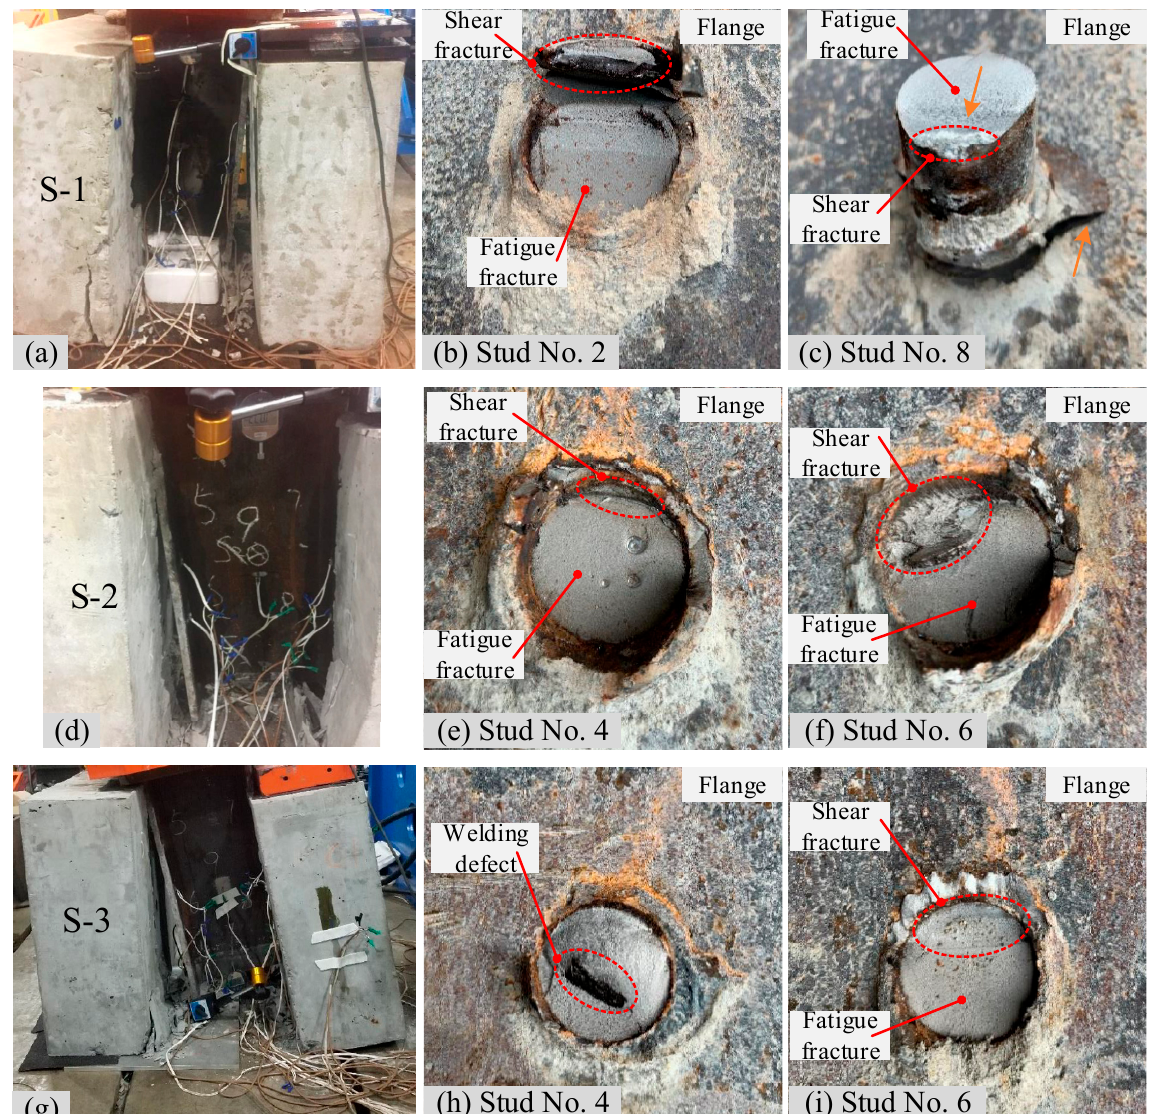
Figure 6. Fatigue failure details of headed shear studs: ( a ) global failure of specimen S-1; ( b ) stud No. 2 of specimen S-1; ( c ) stud No. 8 of specimen S-1; ( d ) global failure of specimen S-2; ( e ) stud No. 4 of specimen S-2; ( f ) stud No. 6 of specimen S-2; ( g ) global failure of specimen S-3; ( h ) stud No. 4 of specimen S-1; ( i ) stud No. 6 of specimen S-1.